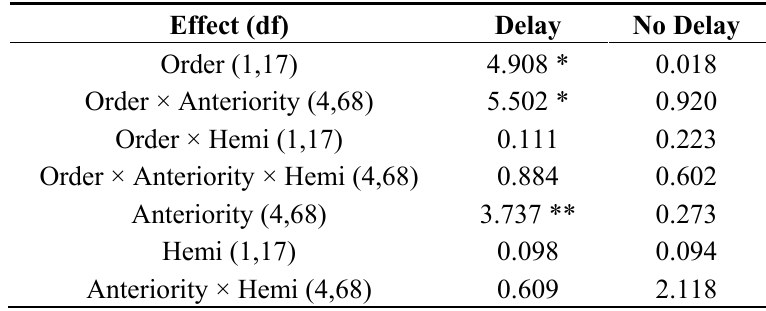
Table 4. Delay versus no-delay, 600–900 ms; results from ANOVA (F-values) for lateral sites.